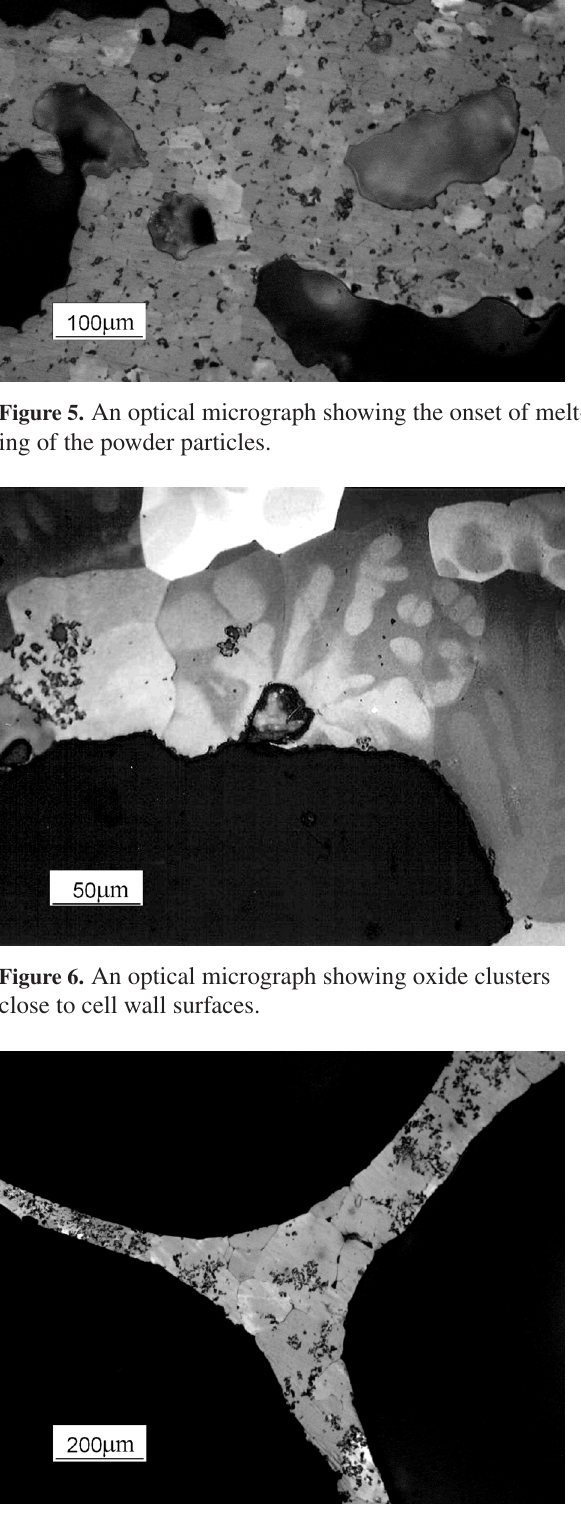
Figure 7. An optical micrograph showing the oxide cluster- ing in cell walls and a Plateau